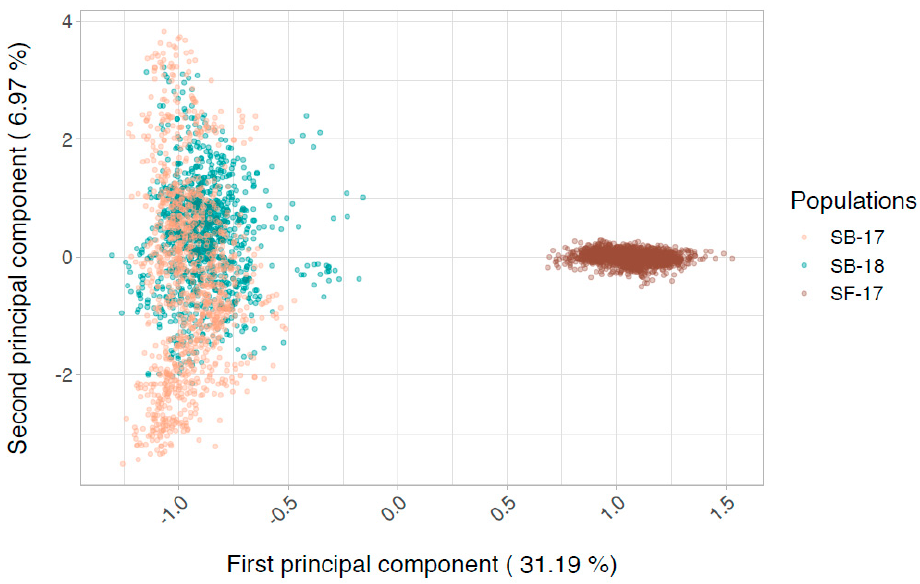
Figure 2. Principal component analysis of the genomic data from different populations of Atlantic salmon, SalmoBreed and StofnFiskur.